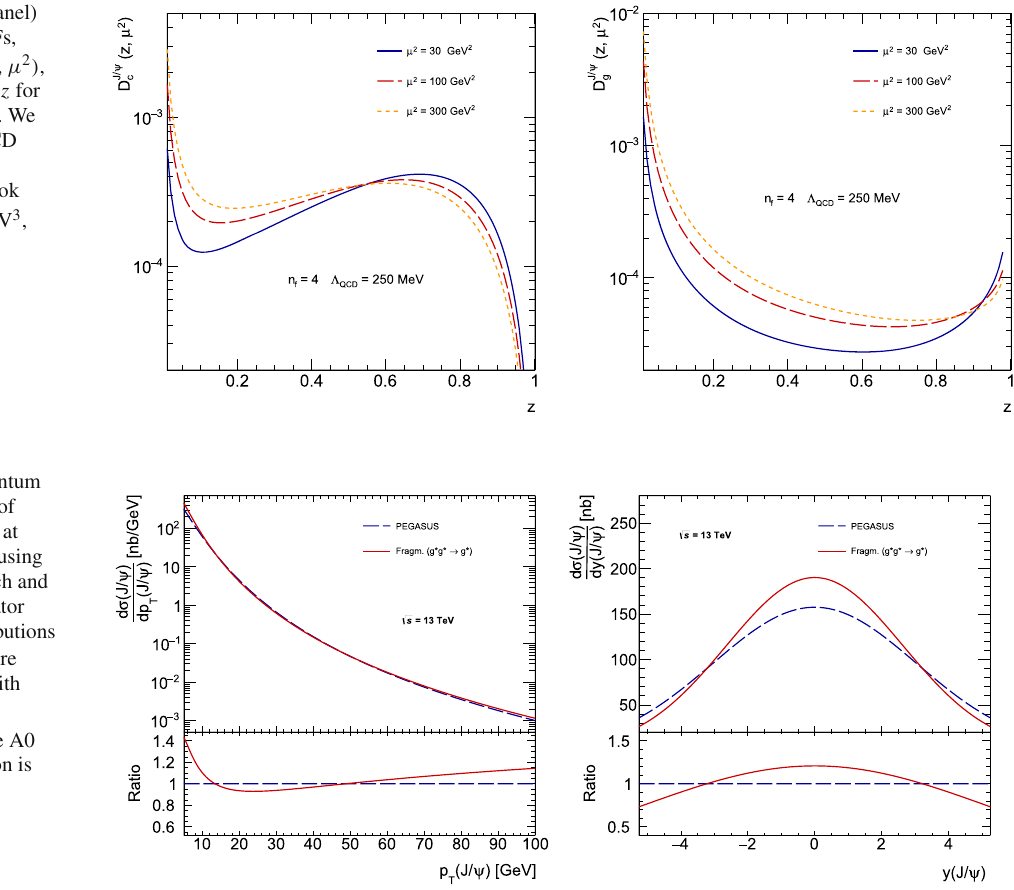
Fig. 4 Transverse momentum and rapidity distributions of inclusive J /ψ production at √ s = 13 TeV, calculated using the fragmentation approach and Monte-Carlo event generator pegasus [63]. The contributions ( 8 ) from the 3 S transition are 1 only taken into account with (cid:8) O J /ψ [ 3 S ( 8 ) ](cid:9) = 1 2 . 5 · 10 − 3 GeV 3 [20]. The